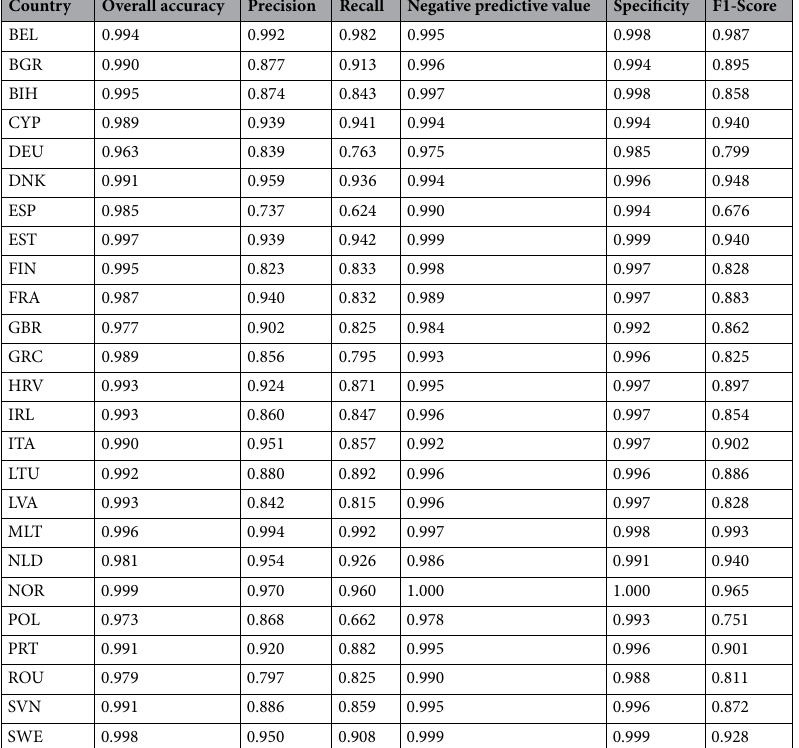
Table 4. Performance measures of the MLP for predicting urban extent in 2012 for every